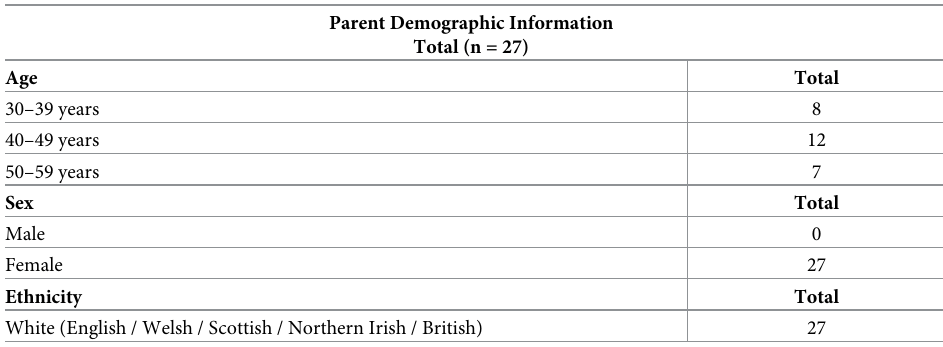
Table 2. Parent demographic